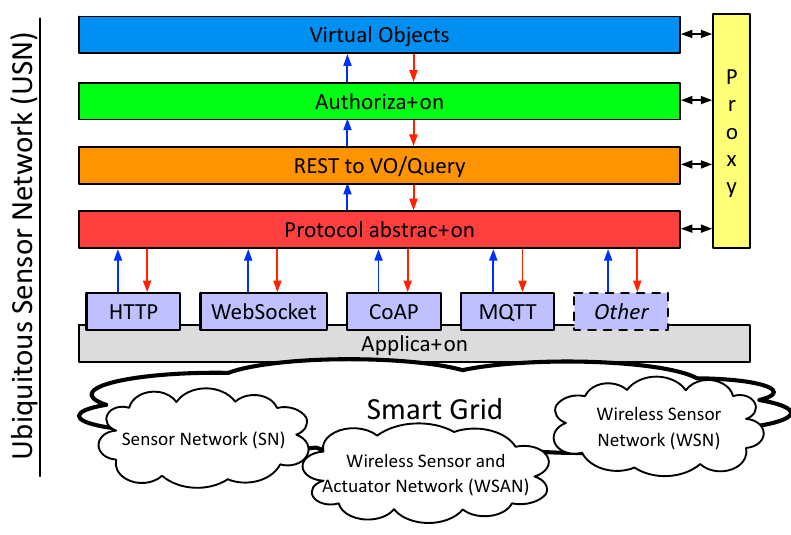
Figure 3. Proposed architecture for the Web of Energy.